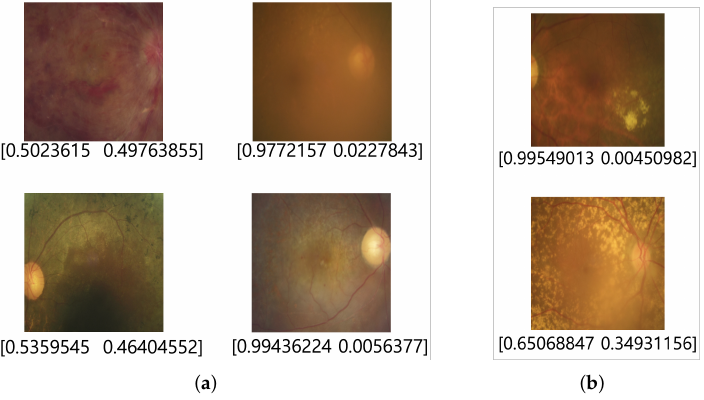
Figure 16. Examples of misclassification of Class B and the probabilities of Softmax: The pair of numbers in parenthesis are the probability values from Softmax. ( a ) Class 3 of Class B; ( b ) Class 4 of Class B.